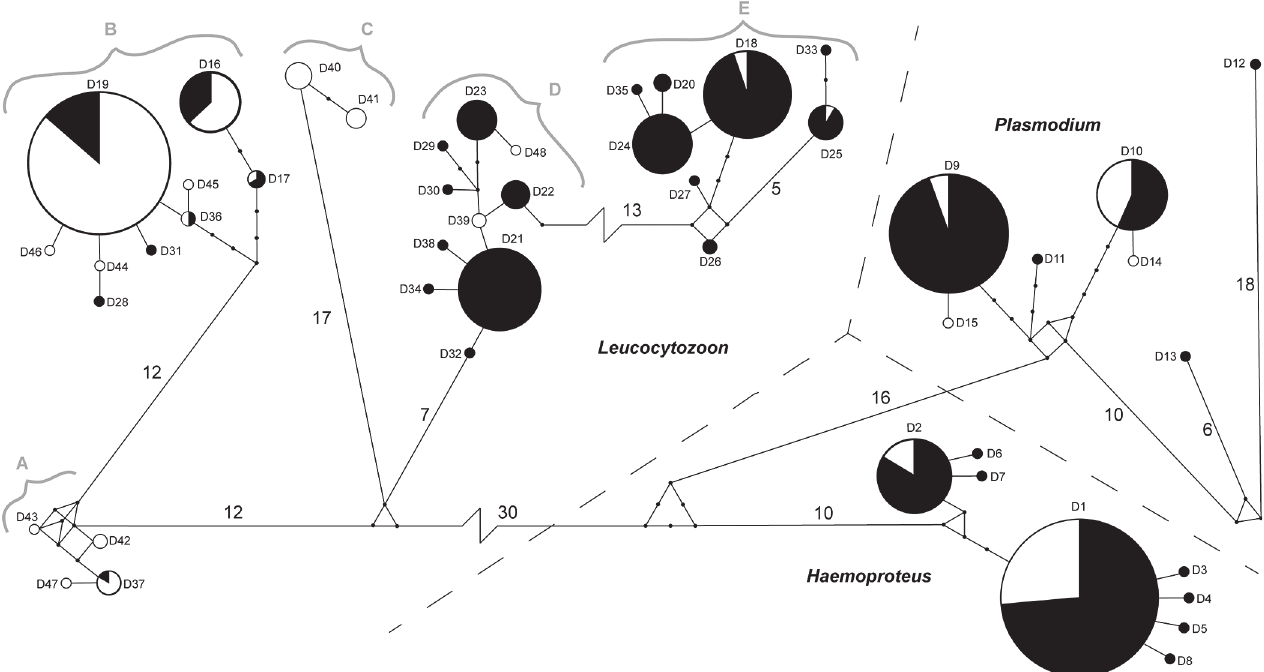
Fig 1. Minimum spanning network constructed from 48 haplotypes of a 386 base pair region of the Cytochrome b gene for haemosporidian parasites detected in ducks of the Pacific Americas Flyway. Circles are drawn proportional to the frequency at which the haplotypes were observed. Shading of circles represents the proportional geographic origin of samples (black = Alaska; white = California). Line segment lengths are proportional to the number of nucleotide differences between haplotypes unless indicated by a line break. Small dots are used to indicate predicted but undetected haplotypes closely related to our data ( < 5 mutations) while numbers adjacent to line segments correspond to larger distances ( (cid:2) 5 mutations). The three genera of blood parasites are separated by dashed lines. Haplotype names as they appear in Table 2 have been abbreviated here (e.g. D4 = DUCK04). Gray letters and brackets correspond to Leucocytozoon clades identified in Fig. 5.